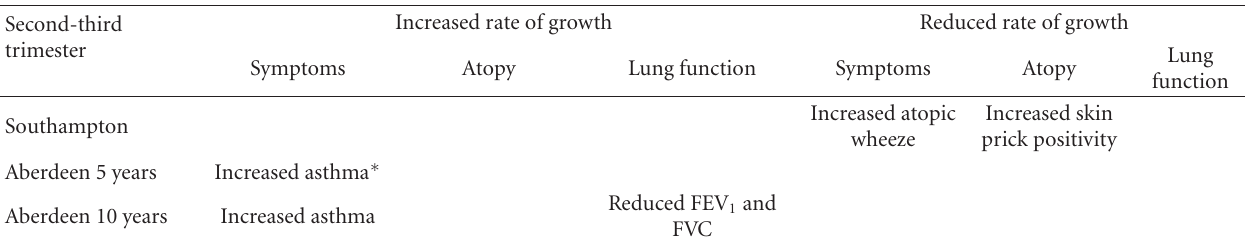
Table 3: Summary of asthma and allergy outcomes in the context of changing growth trajectory during late